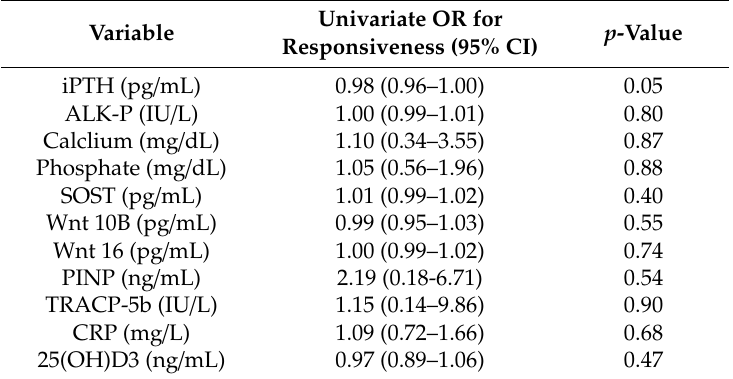
Boldface indicates where the values di ff er significantly between responders and non-responders ( p = 0.046). 25(OH)D3, 25-HydroxyvitaminD;ALK-P,alkalinephosphatase; CRP,C-reactiveprotein; iPTH,parathyroidhormone; PINP, procollagen type I propeptides; SOST, sclerostin; TRACP-5b; tartrate-resistant acid phosphatase